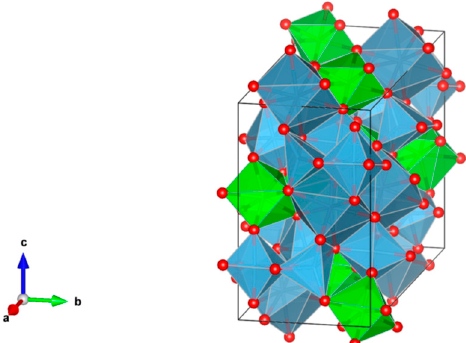
Figure 5. Zirconolite. CaZrTi 2 O 7 , Structure monoclinic, Sp. gr. C2 / c. Cations can be Gd, Hf, Ce, Th, U, Pu and Nb.